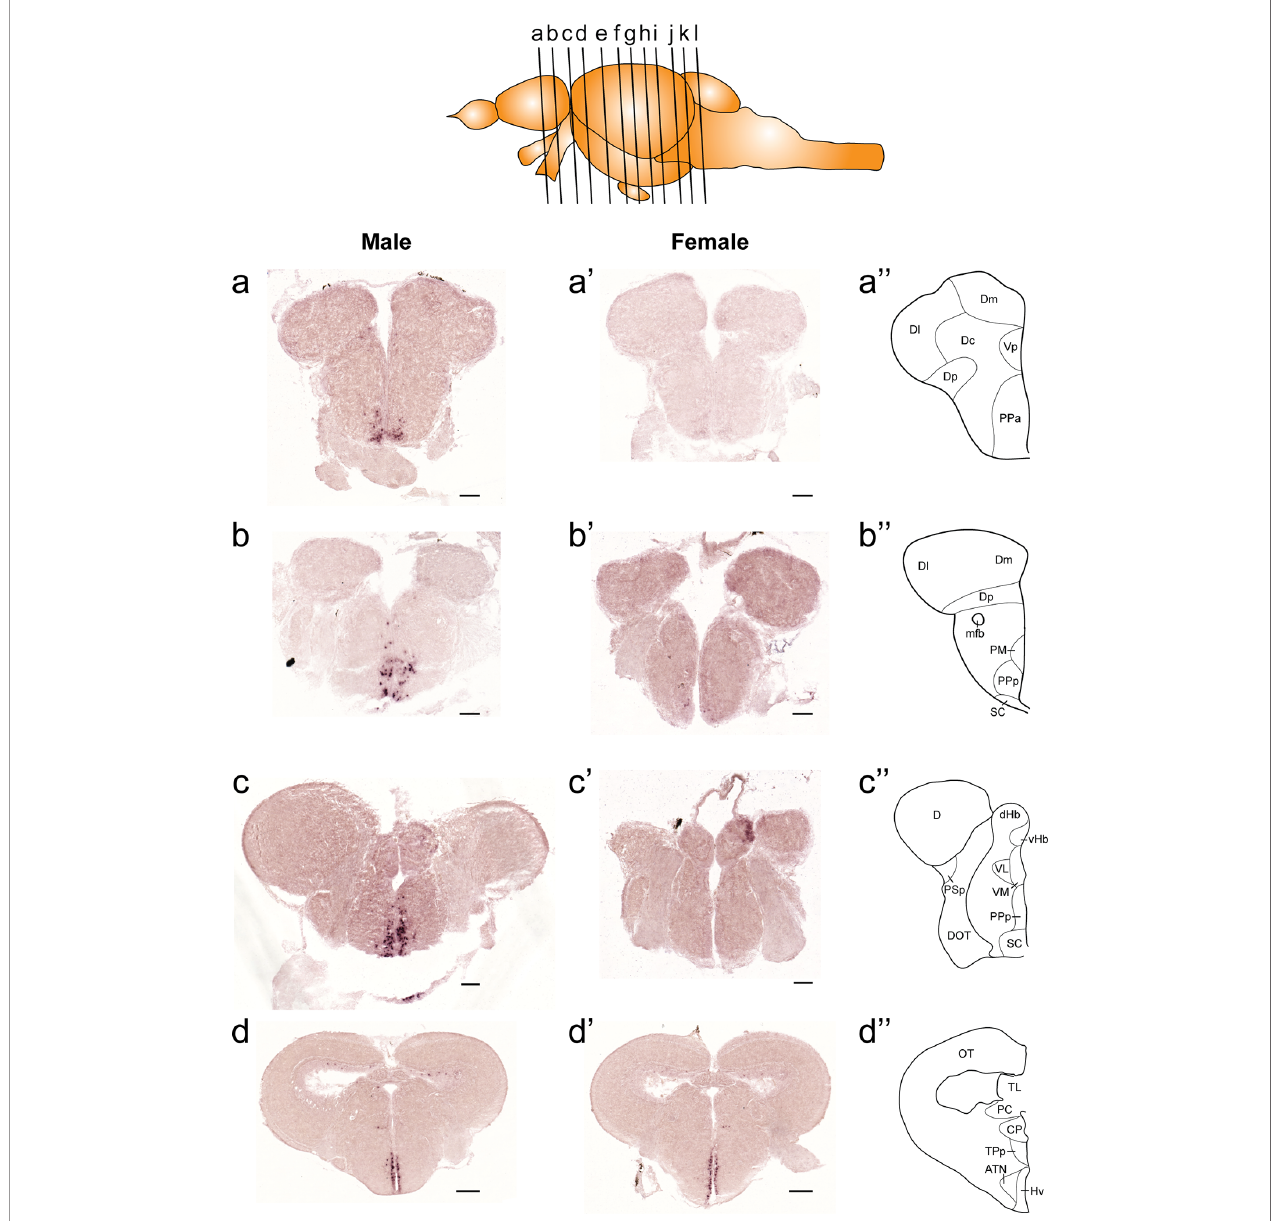
FIGURE 1 | Comparison of expression patterns of tac1 mRNA in the forebrain regions of male (A − D) and female (A ’ − D ’ ) zebra fi sh. In the top panel, a schematic drawing of an adult zebra fi sh brain (lateral view) showing levels of cross-sections presenting in Figures 1 − 3 . Alphabets represent respective fi gure numbers ( A − D : Figure 1, E − H: Figure 2, and I − L: Figure 3 ). In the most-right panels (A ” − D ” ) , a schematic drawing of half of the brain section (left side) processed for tac1 staining indicating major brain structures at this level. There was a sexually dimorphic expression of tac1 in the anterior part of the parvocellular preoptic nucleus (A , A ’ ) , posterior part of the parvocellular preoptic nucleus (B , B ’ ) , and suprachiasmatic nucleus (C , C ’ ) . In contrast, no sexually dimorphic expression of tac1 was observed in the dorsal habenula (C , C ’ ) and the ventral region of the periventricular hypothalamus (D , D ’ ) . Scale bars: (A – C) , (A ’ – C ’ ) , 100 µm; (D , D ’ ) , 200 µm. See Glossary for